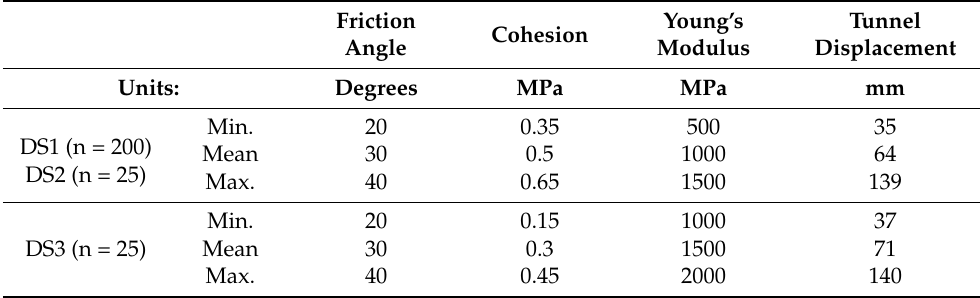
Figure 6. FE model geometry. Table 2. Range of input parameters and tunnel displacement for the datasets.